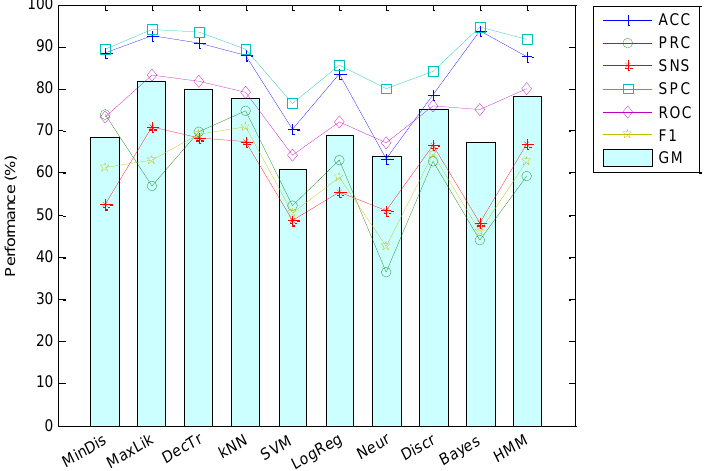
Figure 19. Classification performance using Filter Bank Energy.